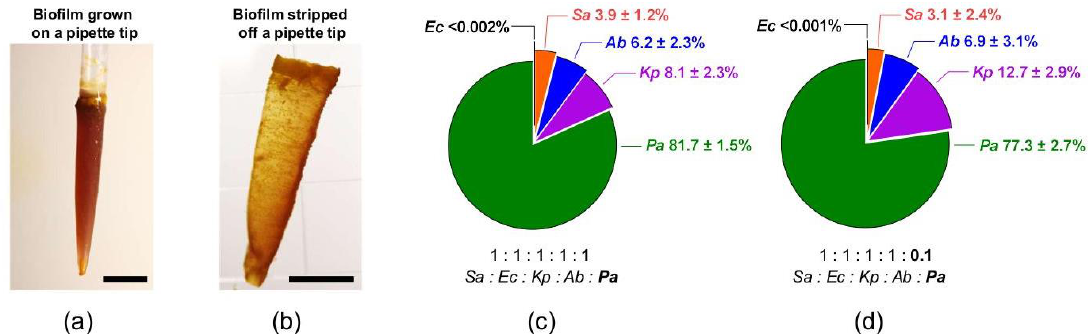
Figure 1. Bacterial composition of polymicrobial biofilms. ( a ) A typical 2-day-old polymicrobial biofilm grown in the LCWPB medium. The five-species biofilm was attached to the surface of a 1 mL pipette tip. ( b ) The opaque and thin biofilm stripped from the pipette tip. Scale bar, 1 cm for ( a , b ). ( c ) Species composition of the polymicrobial biofilm ( n = 6). ( d ) Species composition of the polymicrobial biofilm ( n = 3). The ratios below indicate the initial share of each bacterial inoc- ulum. Sa : S. aureus ; Ec : E. coli ; Kp : K. pneumoniae ; Ab : A. baumannii ; Pa : P. aeruginosa .